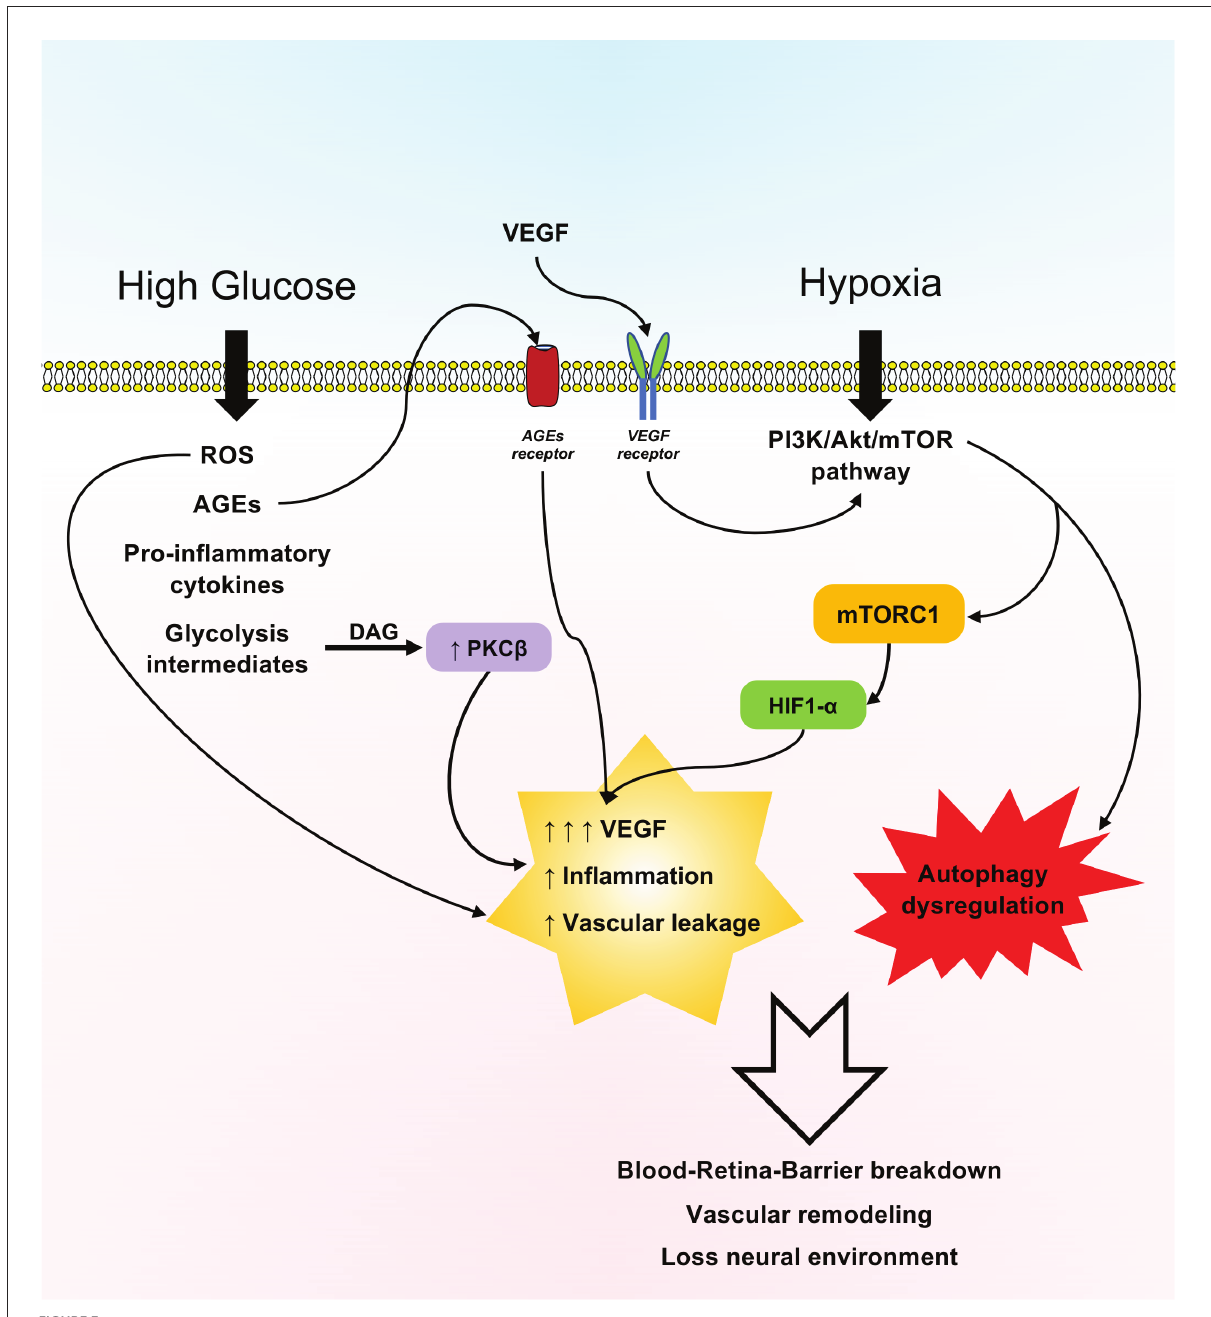
FIGURE3 Schematic representation of the effects of the mTOR pathway in diabetic retinopathy (DR). Hyperglycemia and hypoxia prompt a plethora of effects associated with the expression of the PI3K/Akt/mTOR pathway, reactive oxygen species (ROS), advanced glycation end products (AGEs), inflammatory cytokines, and glycolysis intermediates, which in turn sustain vascular leakage and overall inflammation of the retina, with the loss of the blood–retina barrier and the neural microenvironment being mainly driven by increased vascular endothelial growth factor (VEGF) production and dysregulated